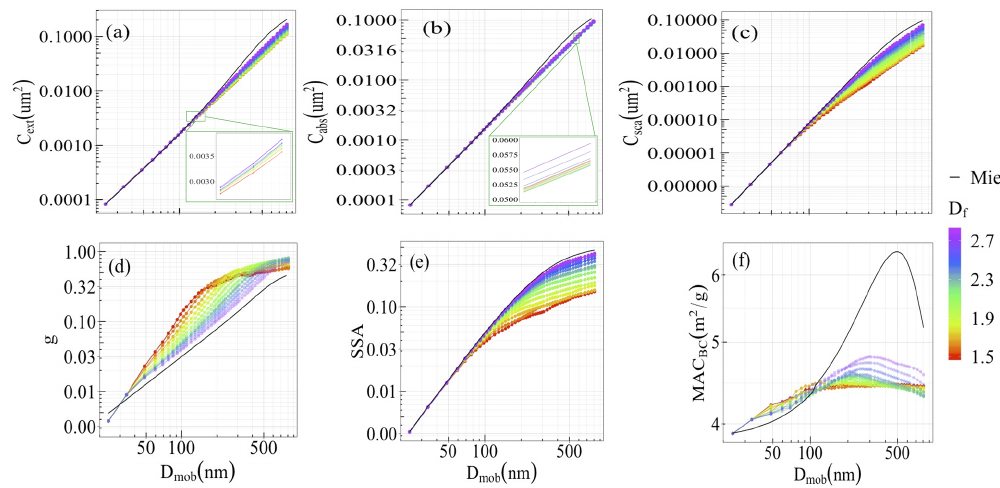
Figure 6. Optical properties of pure BCFAs as a function of D mob at various fractal dimensions ( D f ): (a) extinction cross section C ext , (b) absorption cross section C abs , (c) scattering cross section C sca , (d) asymmetry parameter g , (e) single-scattering albedo (SSA), and (f) black carbon mass absorption cross section MAC BC at λ = 660nm. Radiative results from the Mie calculations are shown by the black line (panels a – f ). The C abs from the Rayleigh–Debye–Gans (RDG) theory is represented by a dashed line (panel b